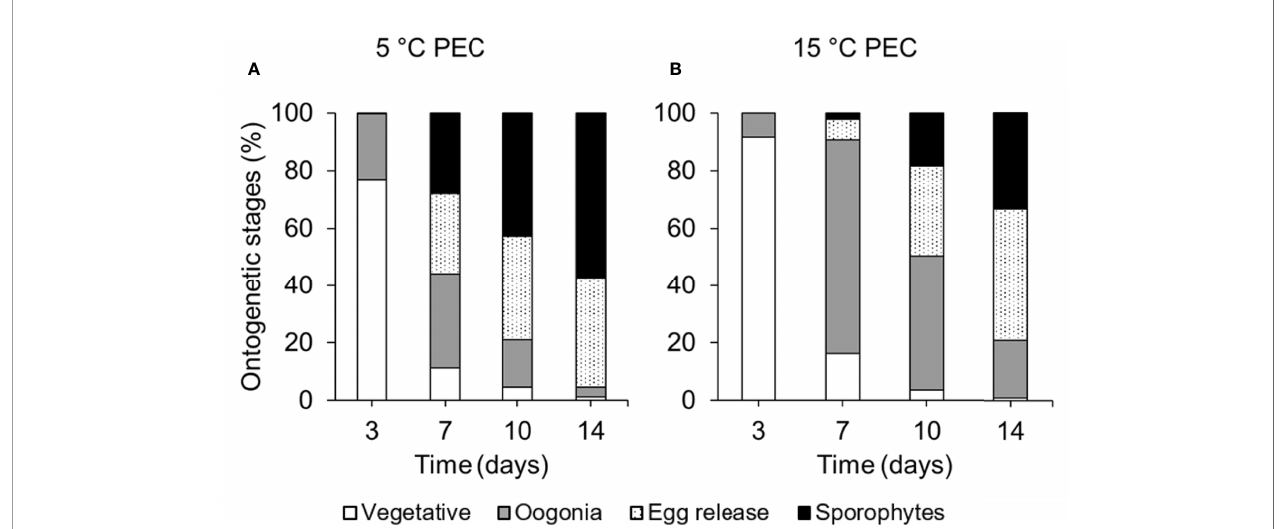
TABLE 3 | Results of chi-square test of homogeneity of variances to investigate differences in proportions of ontogenetic stages of Laminaria digitata gametophytes between pre-experimental cultivation temperatures of 5°C and 15°C at each time point. Day df Sample size